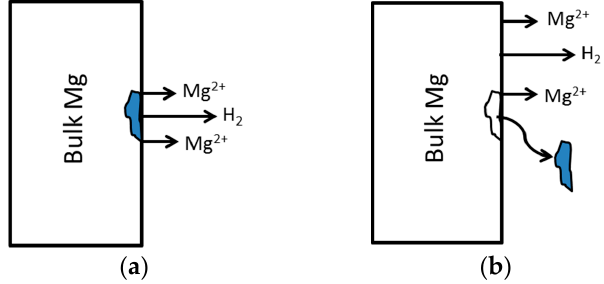
Figure 18. Particle undermining model, at low ( a ) and high ( b ) current density or potential. Modified from [77].